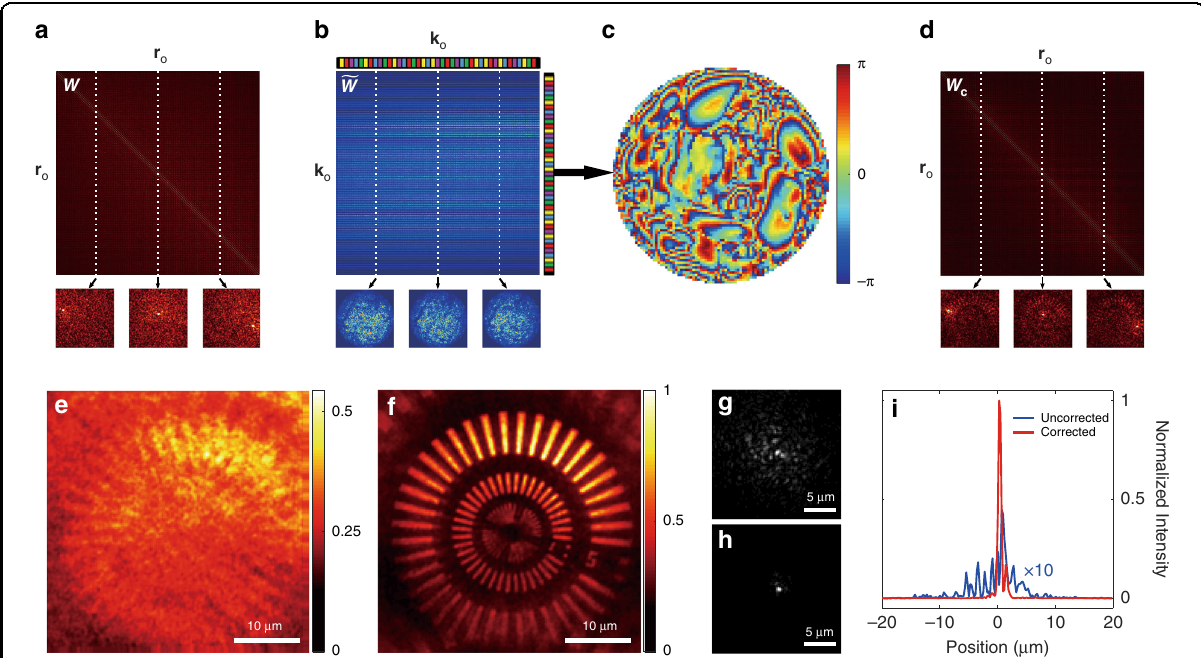
Fig. 3 Wavefront aberration correction using time-reversal matrix. a Fully-sampled time-reversal matrix W ¼ R S R y resolution target underneath a highly aberrating medium. b Time-reversal matrix ~ W in k-space, obtained by the Fourier transform of W . c Wavefront aberration map ϕ o ( k o k ) at the output pupil plane, identi fi ed by the CLASS algorithm. Color bar indicates the phase in radians. d Aberration-corrected time-reversal matrix W c . The subset images in ( a , b , and d ) are 2D E- fi eld images corresponding to columns marked by dashed lines. e , f Uncorrected and corrected images of the Siemens star reconstructed from ~ W and ~ W c , respectively. Images are normalized by the maximum intensity in the corrected image. g , h Uncorrected and corrected intensity-PSFs, respectively. i Line pro fi les of the uncorrected and corrected intensity-PSFs in ( g , h